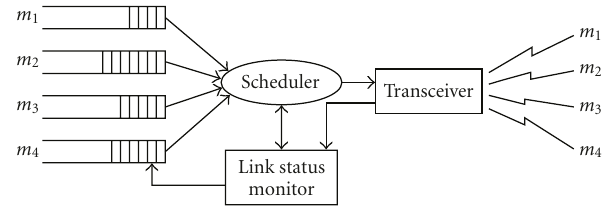
Figure 1: Scheduler model in a BWA network.